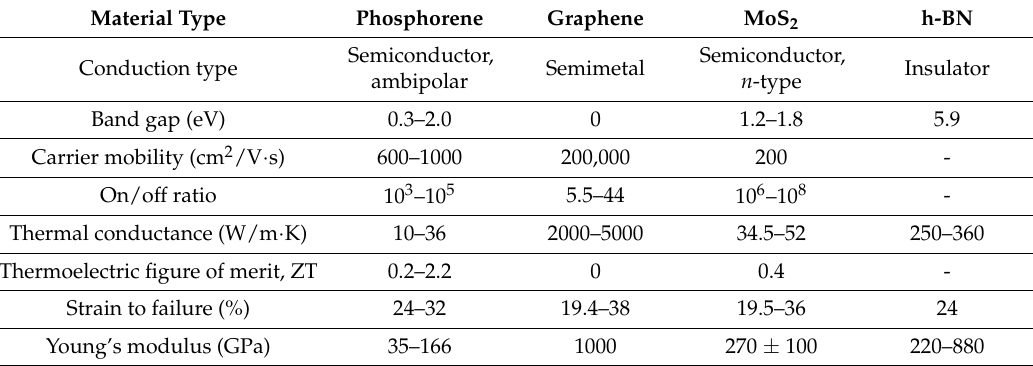
Table 1. A compendium of electronic and mechanical properties of phosphorene, graphene and MoS 2